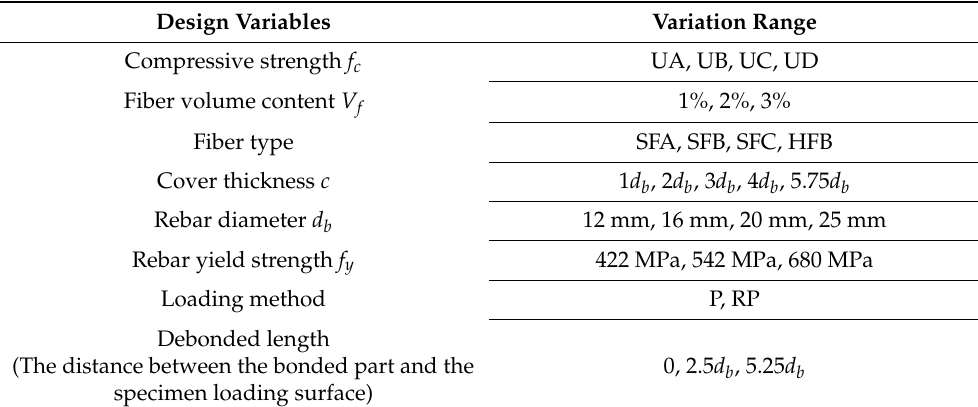
Table 1. Range of design variables.